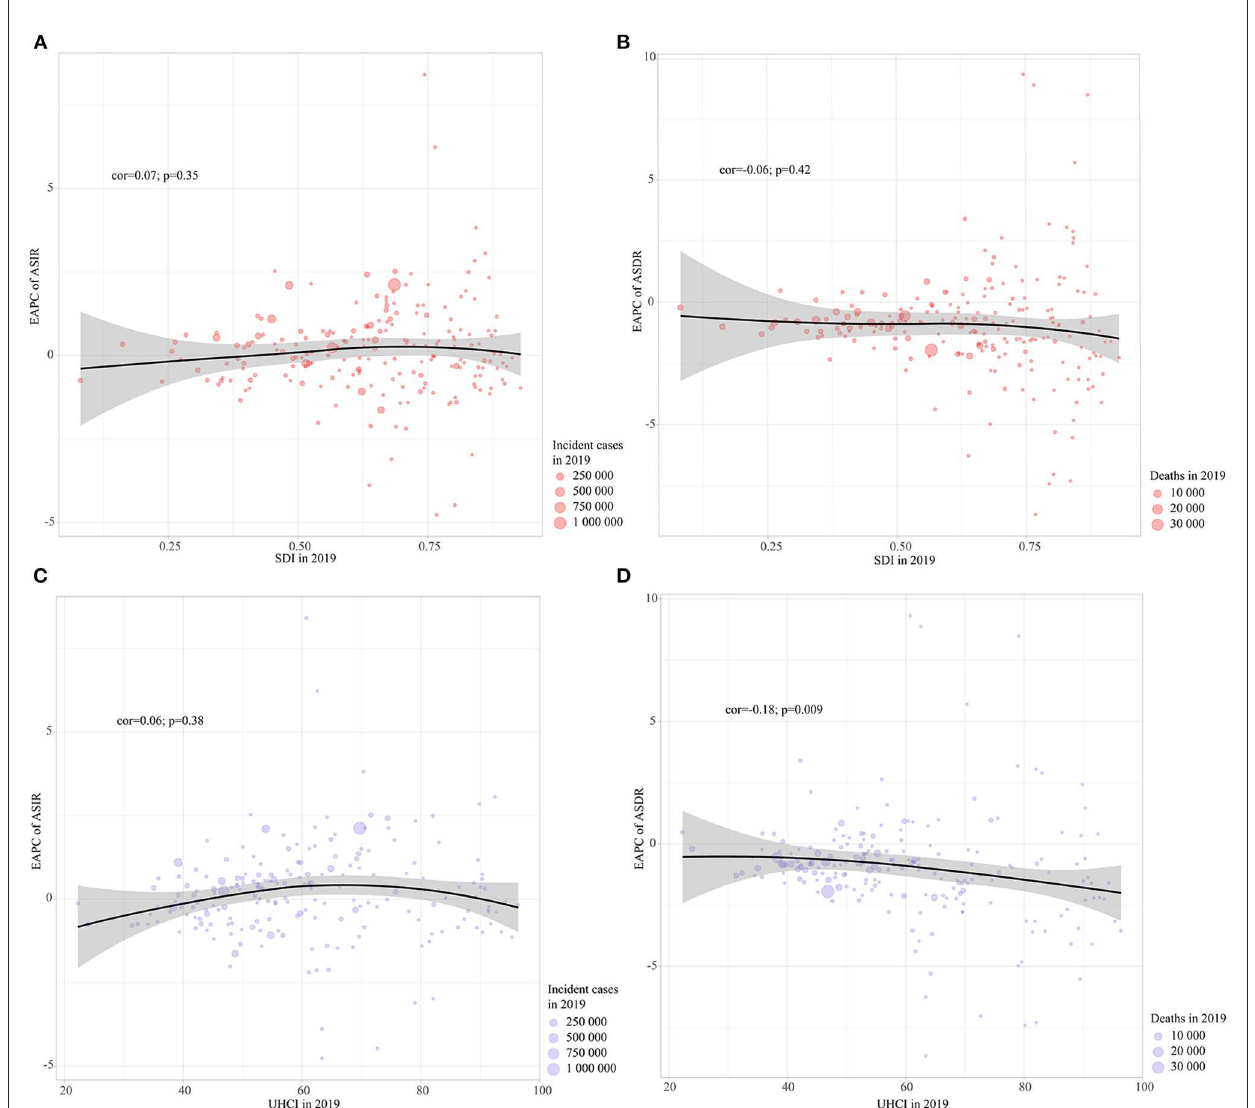
FIGURE5 Pearson correlation was analyzed between EAPCs of ASIRs and ASDRs in NSNIs from 1990 to 2019 and SDI and UHCI in 2019 at the country and territorial levels. (A) SDI in 2019 and EAPC of ASIR; (B) SDI in 2019 and EAPC of ASDR; (C) UHCI in 2019 and EAPC of ASIR; (D) UHCI in 2019 and EAPC of ASDR. The incident cases and deaths of NSNIs from 204 countries and territories in 2019 are represented by circles. The size of the circles increased with the incident cases or deaths of NSNIs. Correlation coefficient, cor.